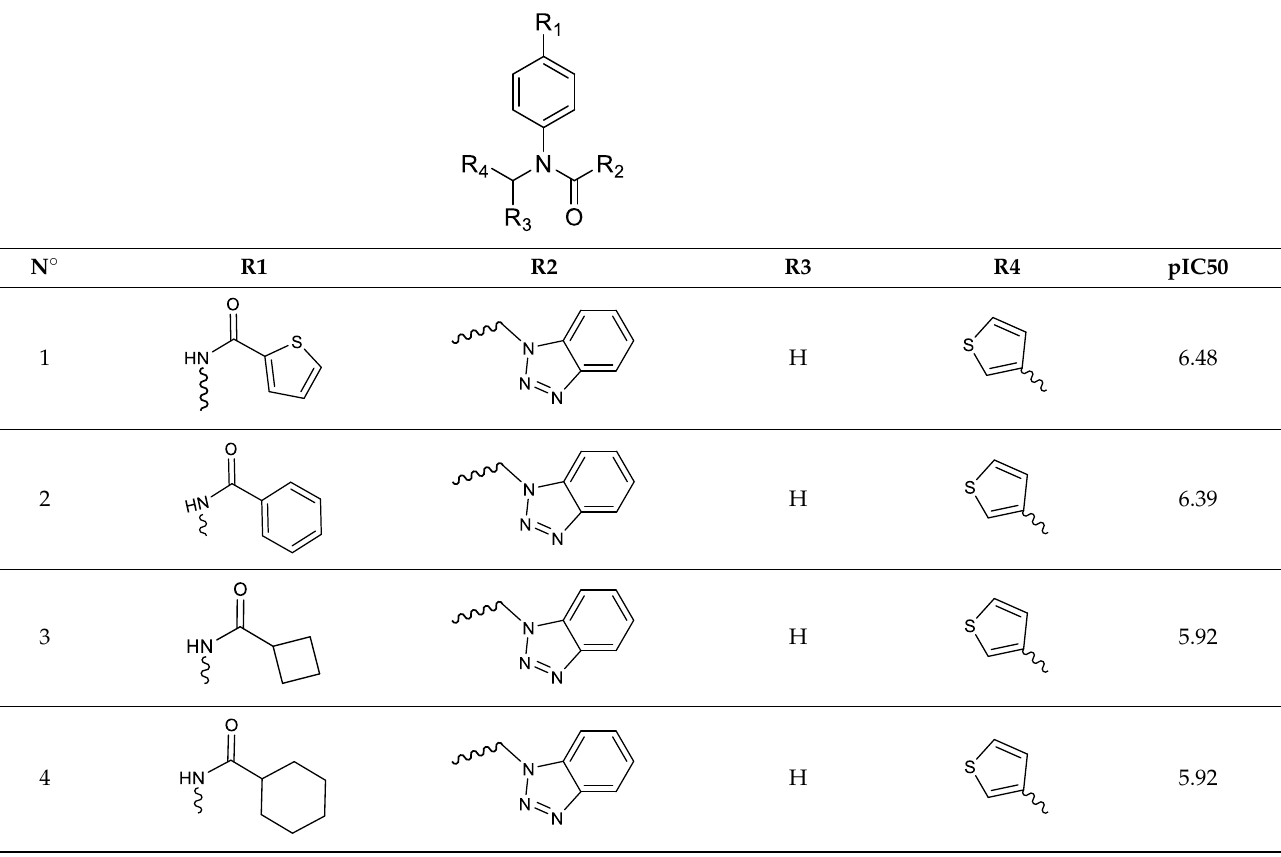
Table 1. Chemical structures and activity experiment of 41 peptidomimetic compounds.